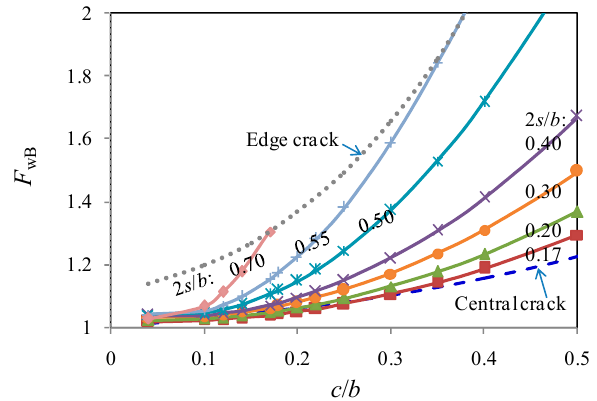
Figure 9. Crack modes in a tension strip.